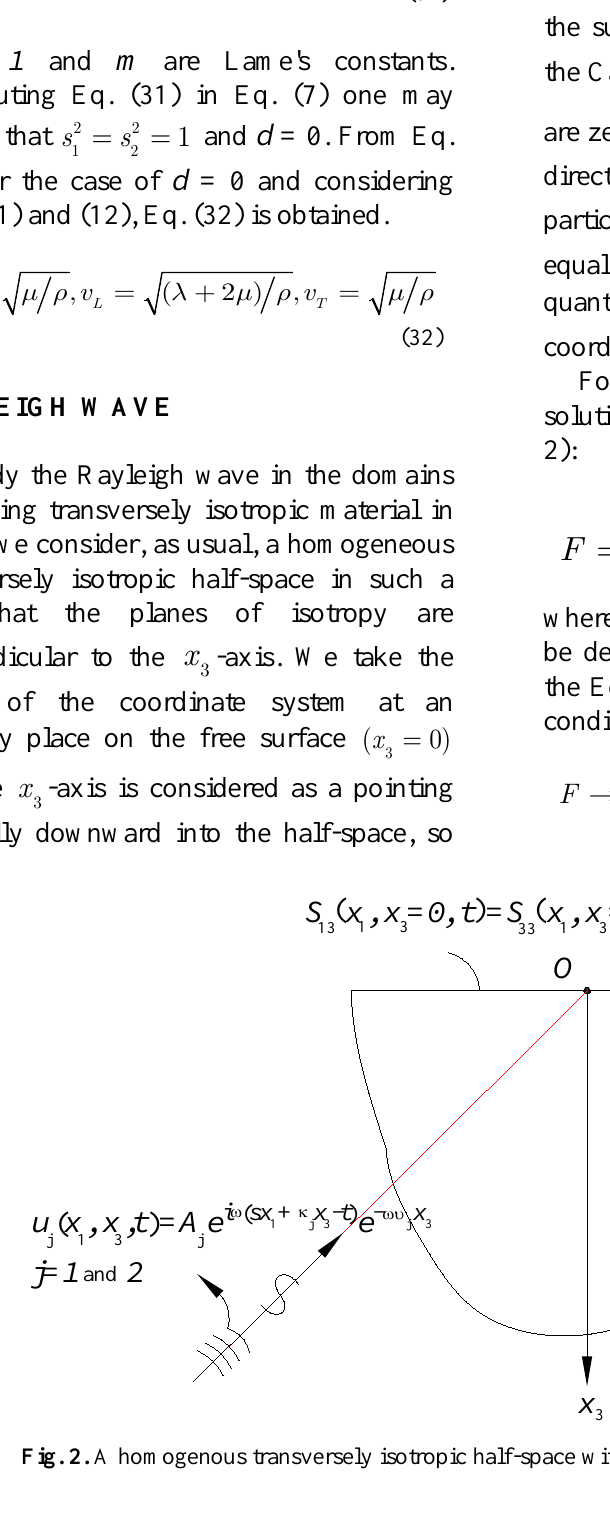
Fig. 2. A homogenous transversely isotropic half-space with an incident wave in